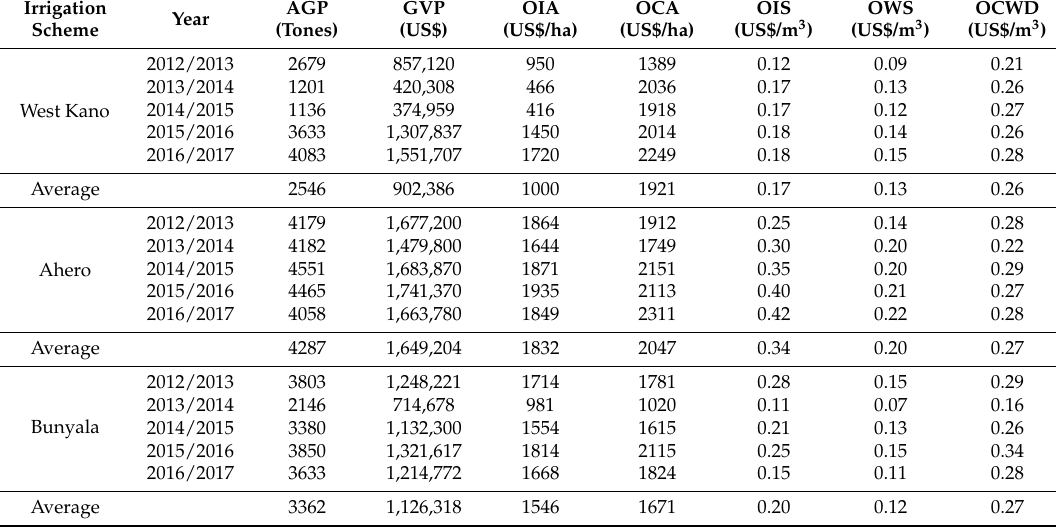
Table 8. Agricultural productivity